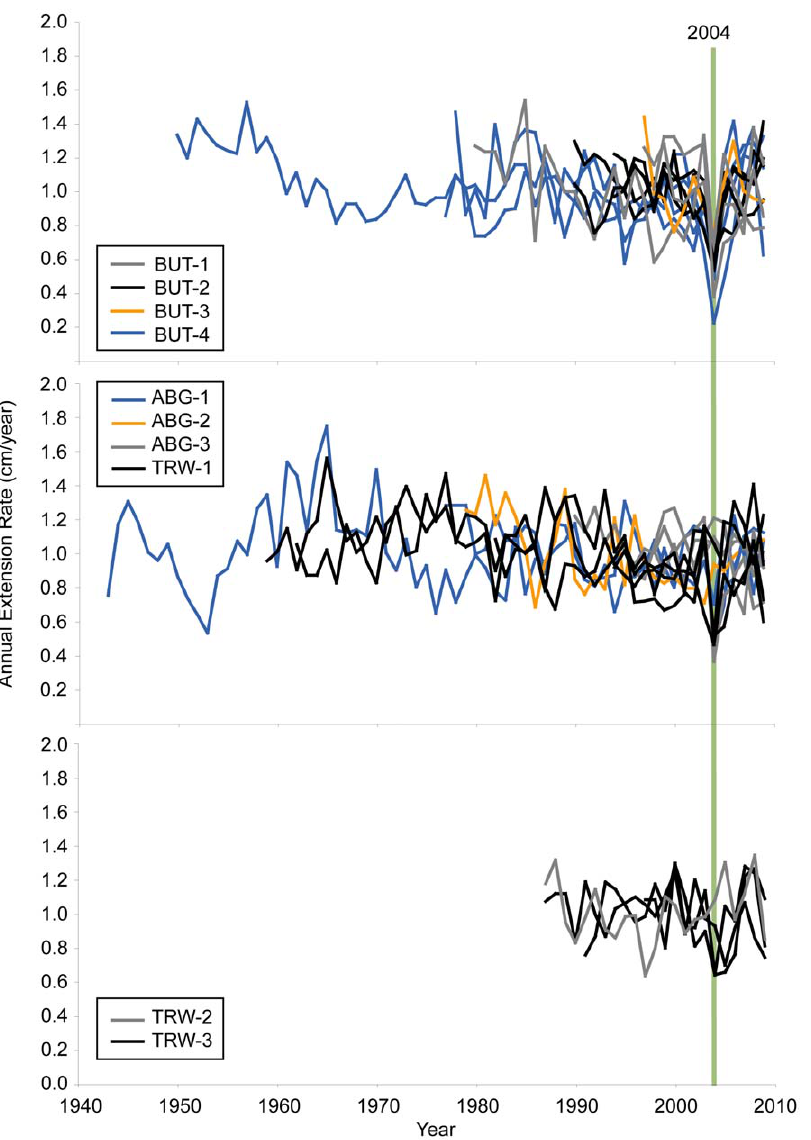
Figure 2. Annual coral extension rates. Extension rates for individual coral cores standardized such that the long-term average for each record is equal to 1 cm/year.